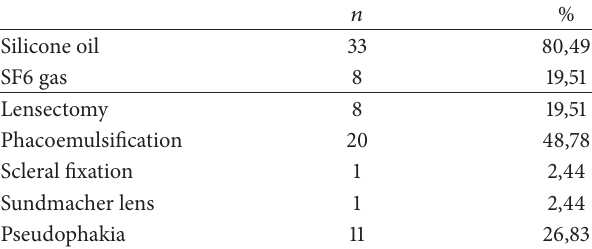
Table2:Intraoperativefindingsduringvitrectomy(typeoftampon- ade silicone oil or sulfur hexafluoride (SF6) gas and status of the